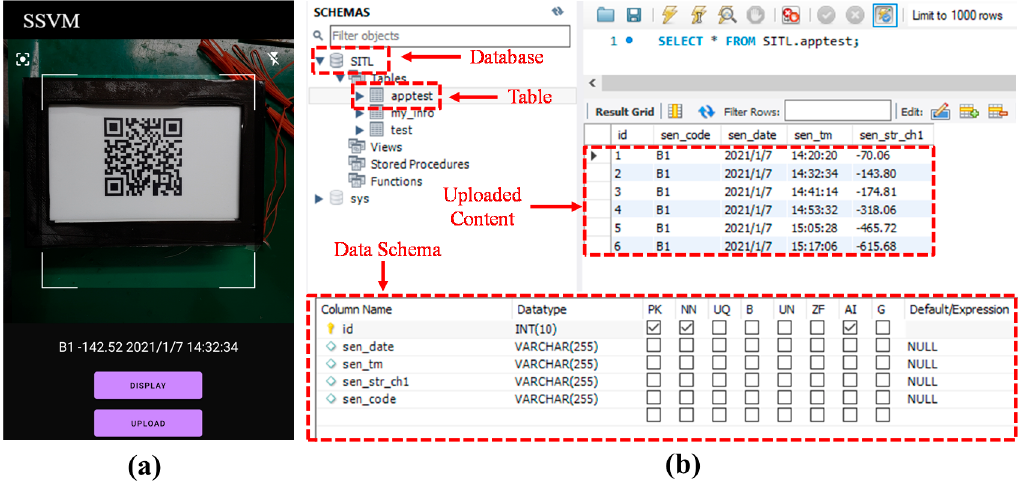
Figure 10. ( a ) Smartphone application; ( b ) cloud database (DB).